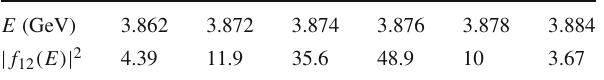
Table 1 The values of the | f 12 ( E ) | 2 near the channel thresholds for the transition 1) – D ∗+ D 0 → D ∗ 0 D +